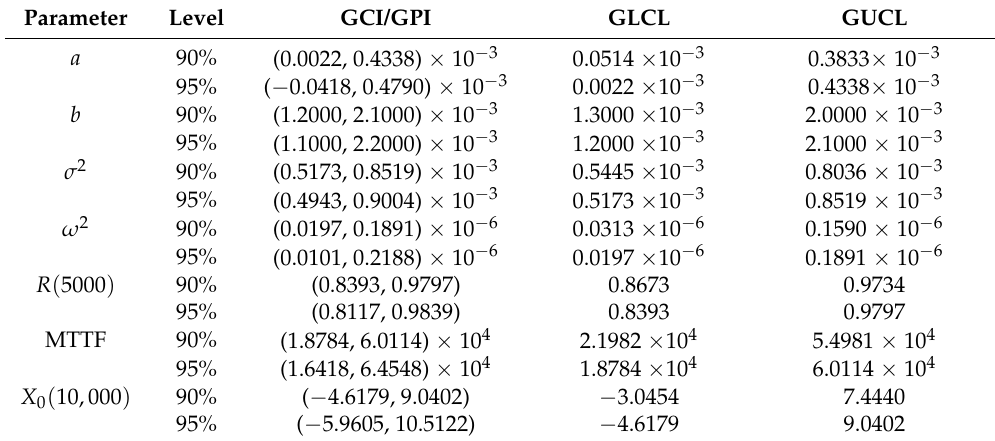
Table 7. The GCIs (GPIs), GLCL and GUCL of model parameters and some